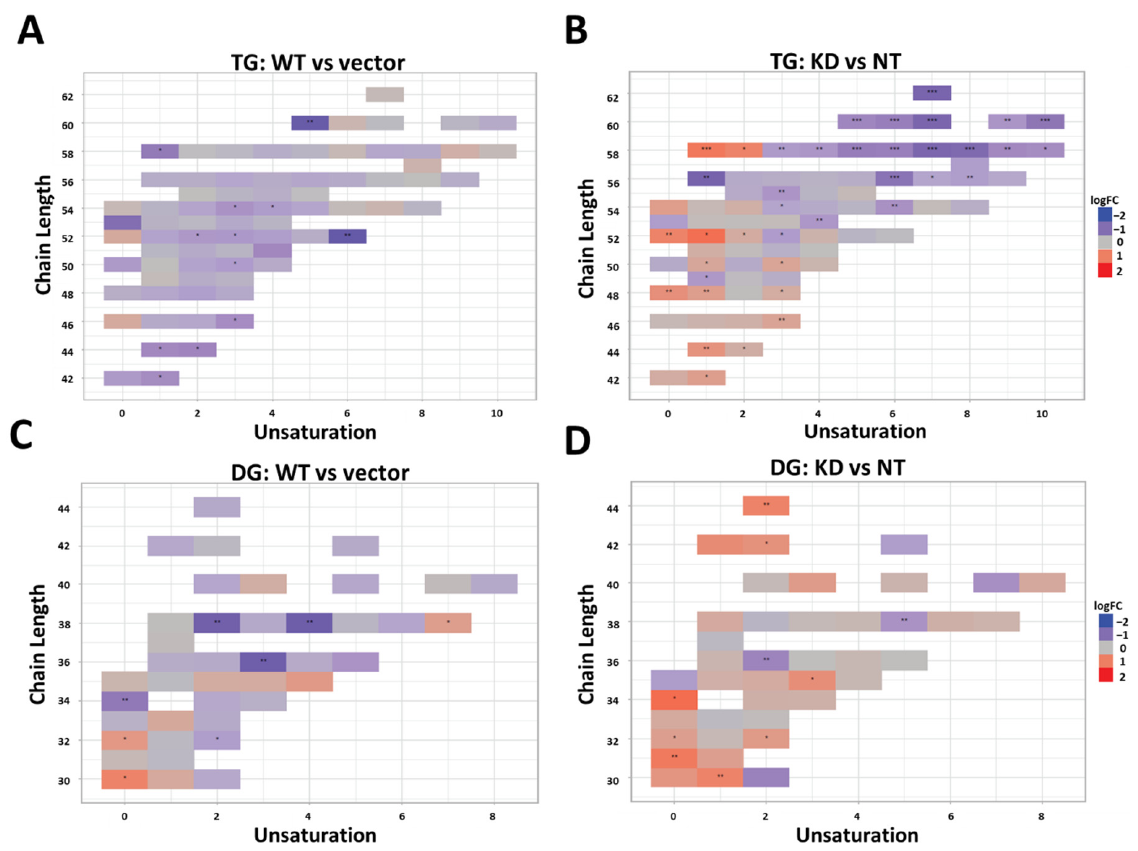
Figure 3. Knockdown of TM6SF2 decreases longer and more unsaturated TGs and DGs. Heatmap shows the distribution of individual TGs ( A , B ) and DGs ( C , D ) across total degree of unsaturation and the side chains lengths. Each box represents an individual lipid species where the colors indicate the relative ratio of the lipid (red: increased; white: no difference; blue: decreased) in ( A , C ) wild-type overexpression ( n = 3) compared to vector control ( n = 3) and ( B , D ) TM6SF2 knockdown ( n = 5) versus non-targeting control ( n = 4). Lipids with statistically significant difference between the experimental and control cells are highlighted. * p < 0.05, ** p < 0.01, *** p < 0.001. Wild-type TM6SF2 (WT), pCMV empty vector control (Vector), non-targeted shRNA control (NT), and TM6SF2 knockdown (KD).